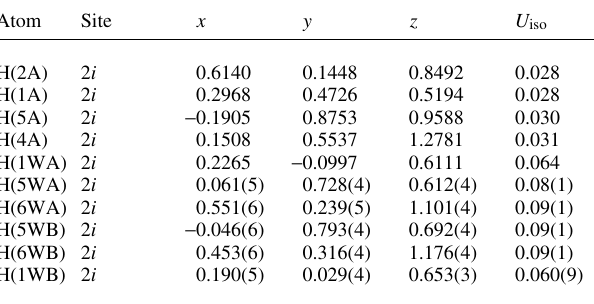
Table 2. Atomic coordinates and displacement parameters (in Å 2 )